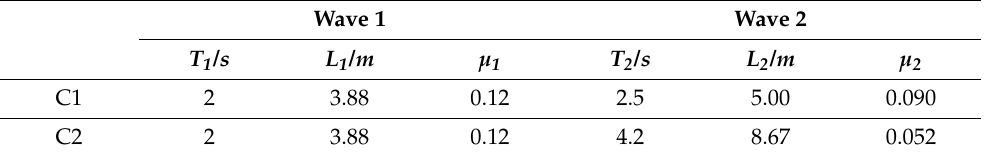
Table 1. Simulated working conditions with two-color waves at a uniform water depth.